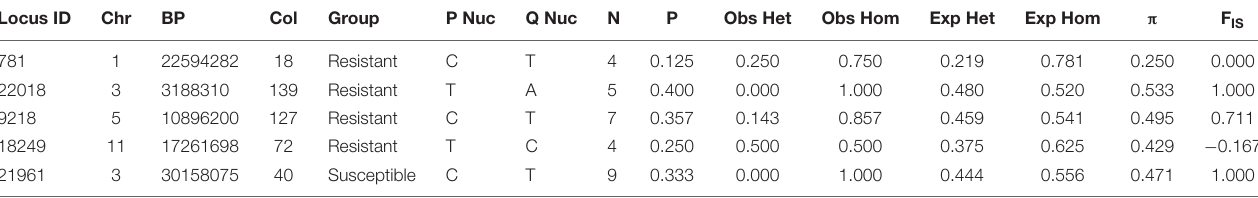
TABLE 6 | List of private alleles that were specifically polymorphic in either Resistant or Susceptible group. Locus ID